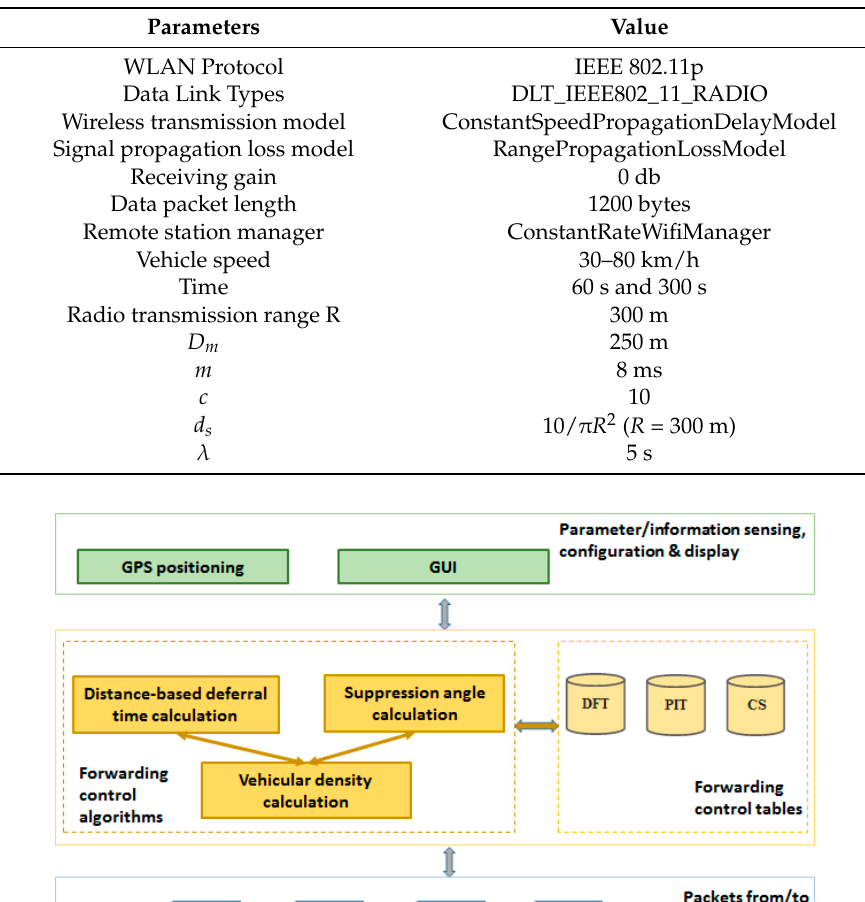
Table 1. Parameters for the simulations.